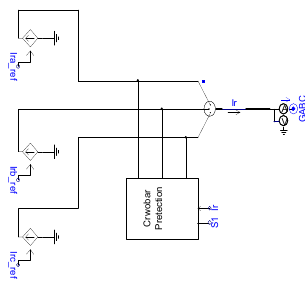
Figure A6. Rotor side of the average model of DFIG.